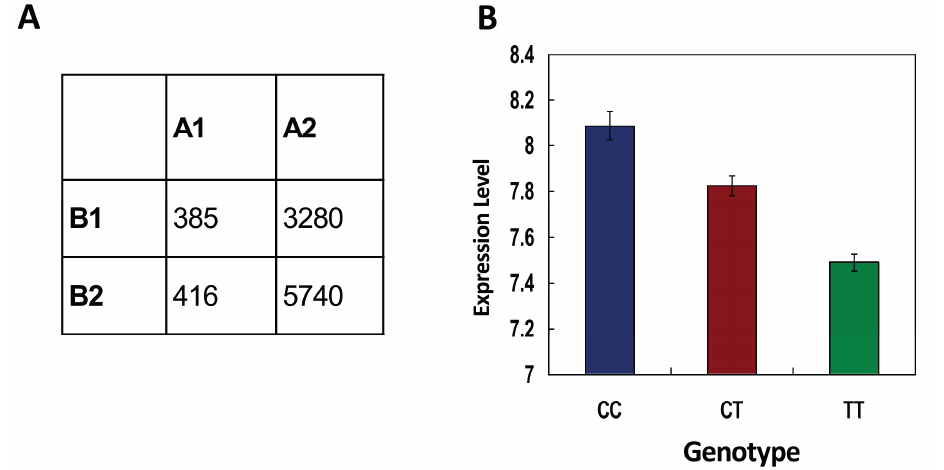
Figure 3. Evidence for the model from large-scale analysis of correlation between genotype and gene expression. The category table represents the relationship between synonymous SNPs changing miRNA regulation and gene expression ( A ). A1—Significant-correlation between gene expression and genotype ( p ≤ 0.05); A2—Non-significant-correlation between gene expression and genotype ( p > 0.05); B1—Genes that host synonymous SNPs changing miRNA regulation; and B2—Genes that do not host synonymous SNPs changing miRNA regulation; The sub-figure ( B ) shows the relationship between the genotype at the synonymous SNP (rs2247761) and gene TRIM4 expression